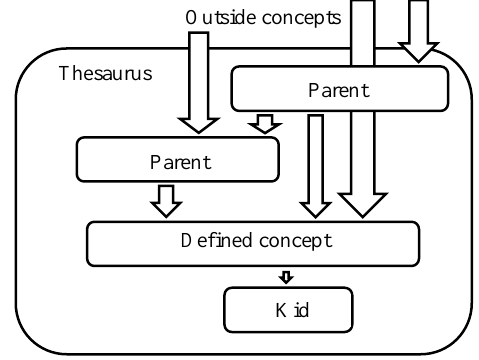
Fig. 1. A learning module as ontological knowledge